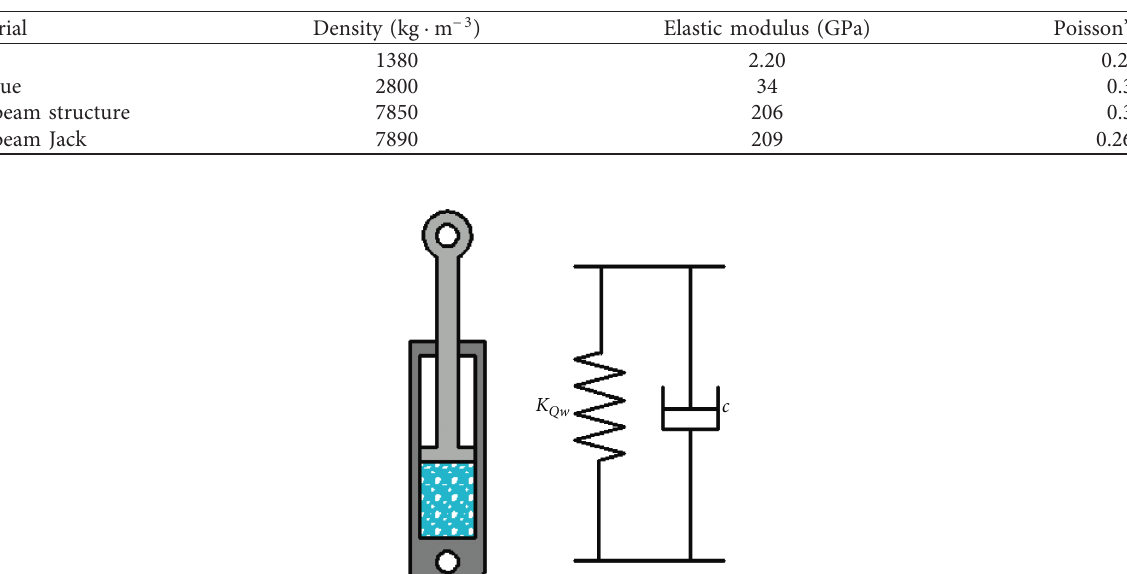
Table 1: Material properties of the simulation model with clearance.